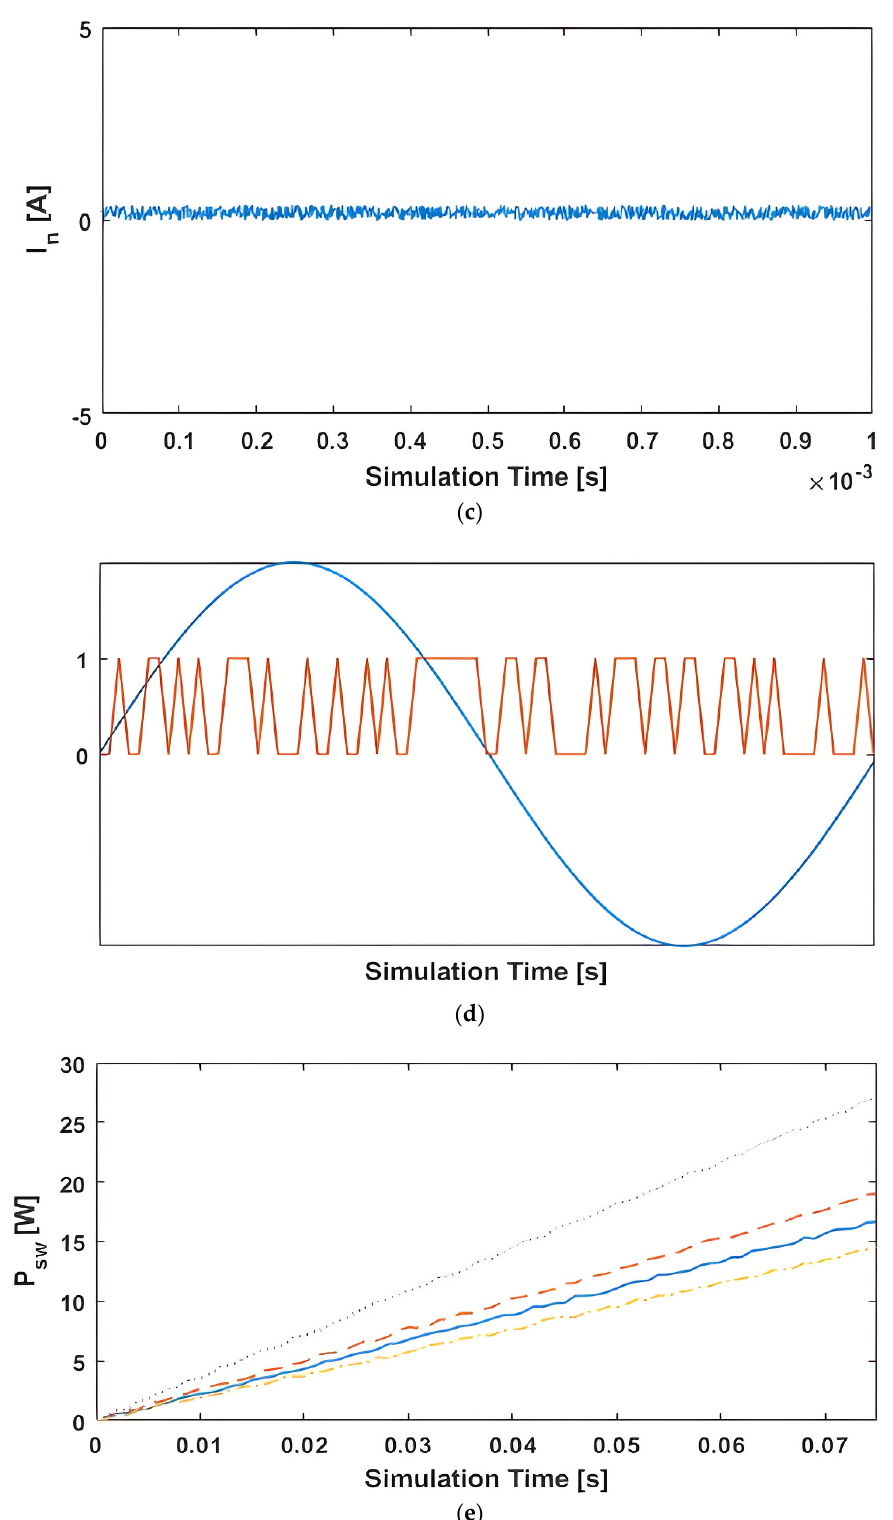
Figure 6. ( a ) V abc -Mode IV with Balanced Reference Currents. ( b ) I abc -Mode IV with Balanced Reference Currents. ( c ) I n -Mode 1V with Balanced Reference Currents. ( d ) Switching frequency for one duty cycle-Mode 1V with Balanced Reference Currents. ( e ) Switching losses-Mode IV with Balanced Reference